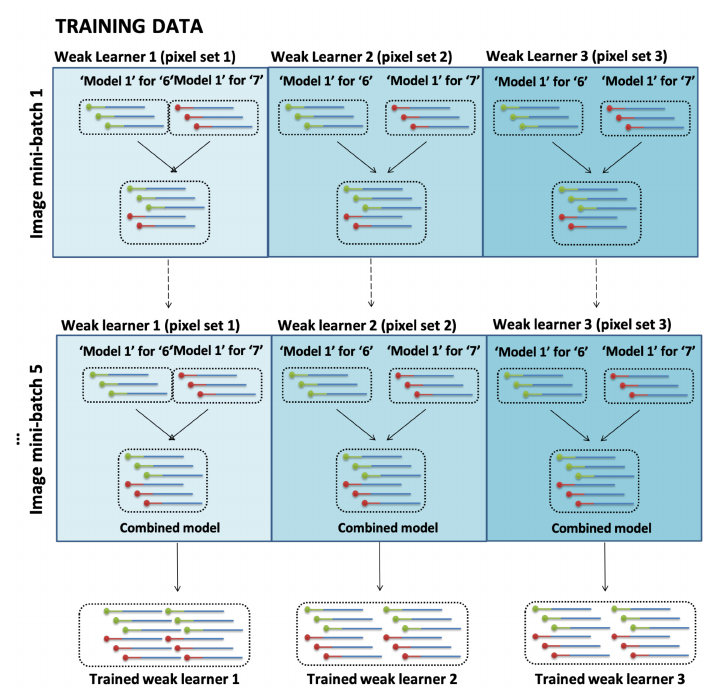
Figure 5. Ensemble of hypernetworks. Three ensembles of both trained models for digit images ‘6’ and ‘7’ are added in an online manner (combined model). The ensembles are added together for ensemble prediction in digit classification in the test